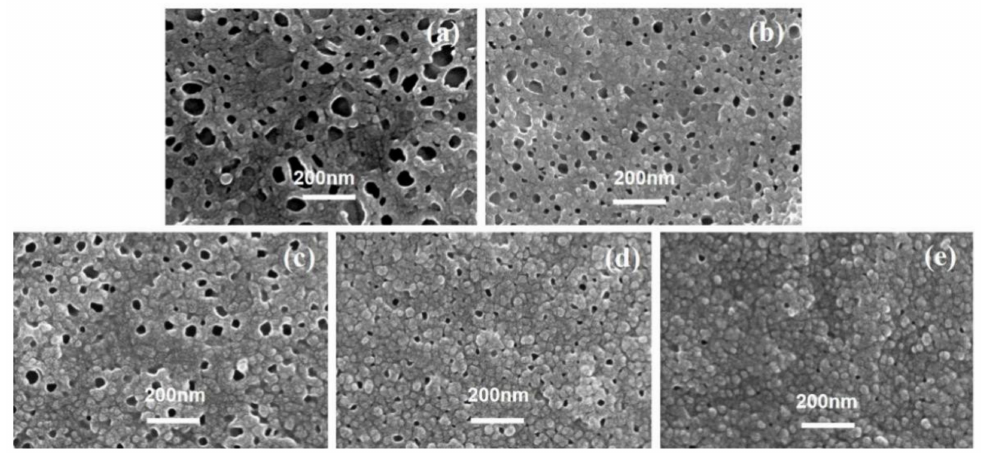
Figure 5. SEM image of PA’s back surface, ( a – e ): TFC − 8~TFC −